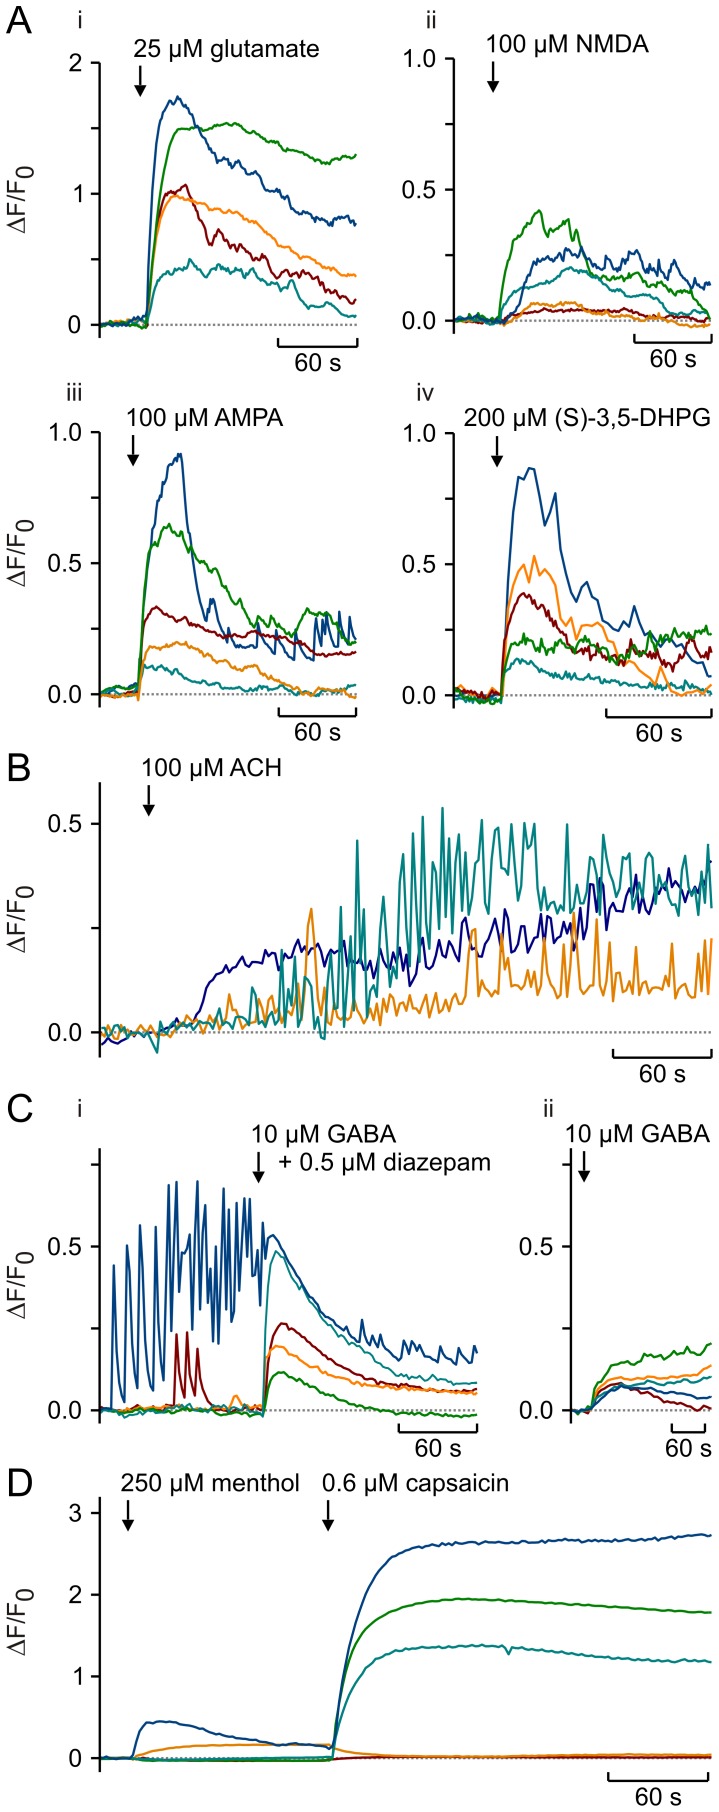
FMP responses during stimulation of neurons with various neurotransmitters.(A) FMP signals elicited by activation of ionotropic and metabotropic glutamate receptors. Retinal ganglion cell (RGCs) were treated with 25 µM glutamate (i), 100 µM NMDA (ii) and 100 µM AMPA (iii). Septal neurons were exposed to 200 µM (S)-3,5-DHPG (iv). (B) Cortical neurons were treated with 100 µM acetylcholine (ACH) resulting in rapid oscillations of the FMP fluorescence. (C) The spontaneous oscillations of the FMP fluorescence observed in some hippocampal neurons were silenced upon addition of 10 µM GABA and 0.5 µM diazepam (i). Addition of 10 µM GABA in the presence (i) and absence (ii) of diazepam slightly enhanced the FMP fluorescence in most hippocampal neurons. (D) Dorsal root ganglion neurons (DRGs) were treated with 250 µM (-)-menthol to activate cold receptors, followed by 0.6 µM (E)-capsaicin to activate heat receptors. Experiments were performed in HBSS. Shown are representative FMP signals of individual neurons depicted in colour.